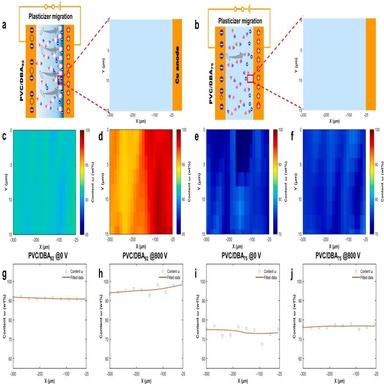
Plasticizer content distribution at migration equilibrium. Schematic illustrating the more pronounced plasticizer migration phenomenon in high plasticizer content PVC/DBA92 (a) compared to low plasticizer content PVC/DBA75 (b) during PVC gel electrostimulation. The region near the anode electrode was used for collecting planar Raman spectra. Raman spectra from a small region of the PVC gel in contact with the anode, affected by the copper anode, were excluded. Comparison of plasticizer content distribution